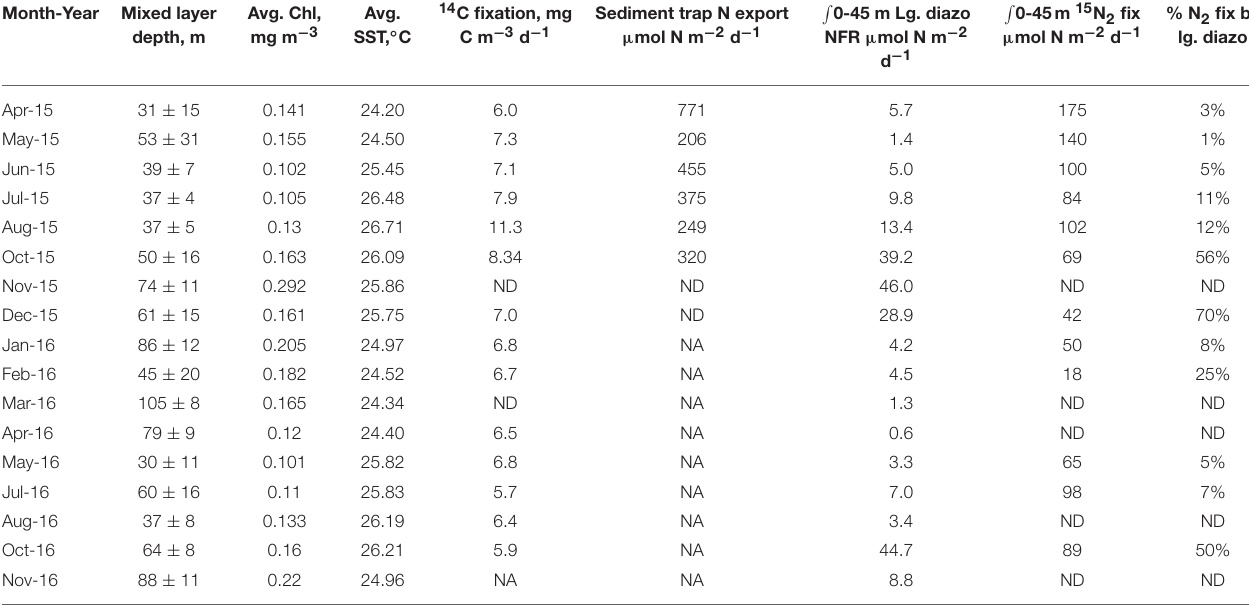
The 0–45 m depth integrated in situ 15 N 2 fixation rate (N 2 fix) measurements is shown and the estimated contribution of large diazotrophs to integrated rates (% N 2 fix by lg. diazo) is calculated as the quotient of N 2 fix estimated for all groups and the measured 0–45 m integrated 15 N 2 fixation rates. ND indicates months when rates of N 2 fixation were not measured. ND indicates values were not determined whereas NA indicates data not yet